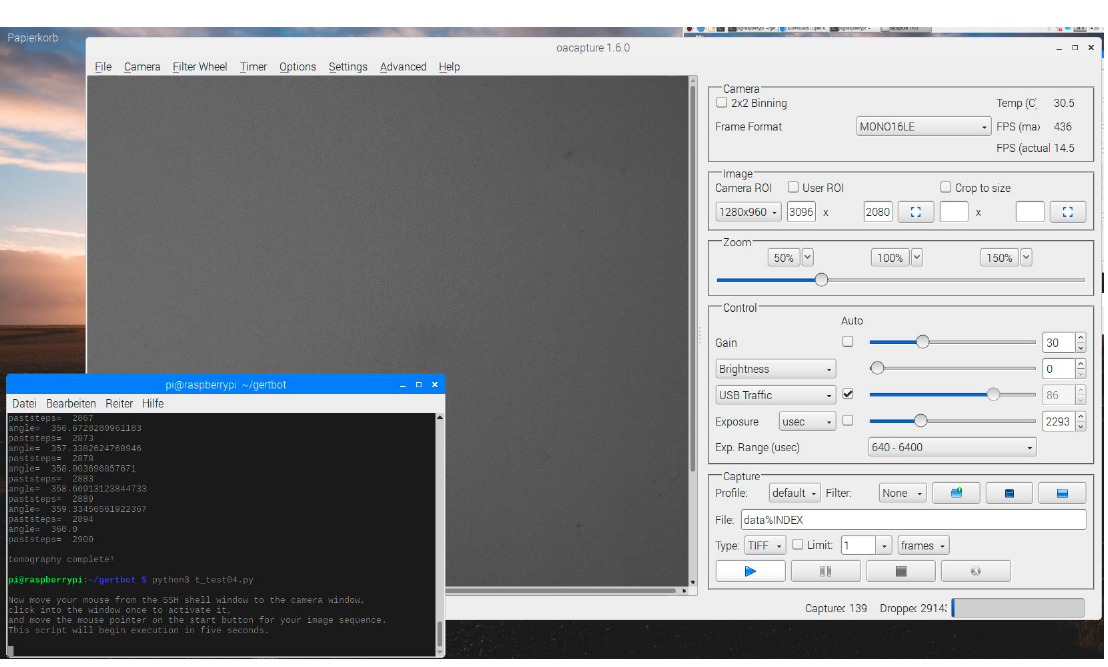
Figure 14. Screen shot of the Astronomy Imaging program oaCapture on the raspberry Pi, with the script window to the left.